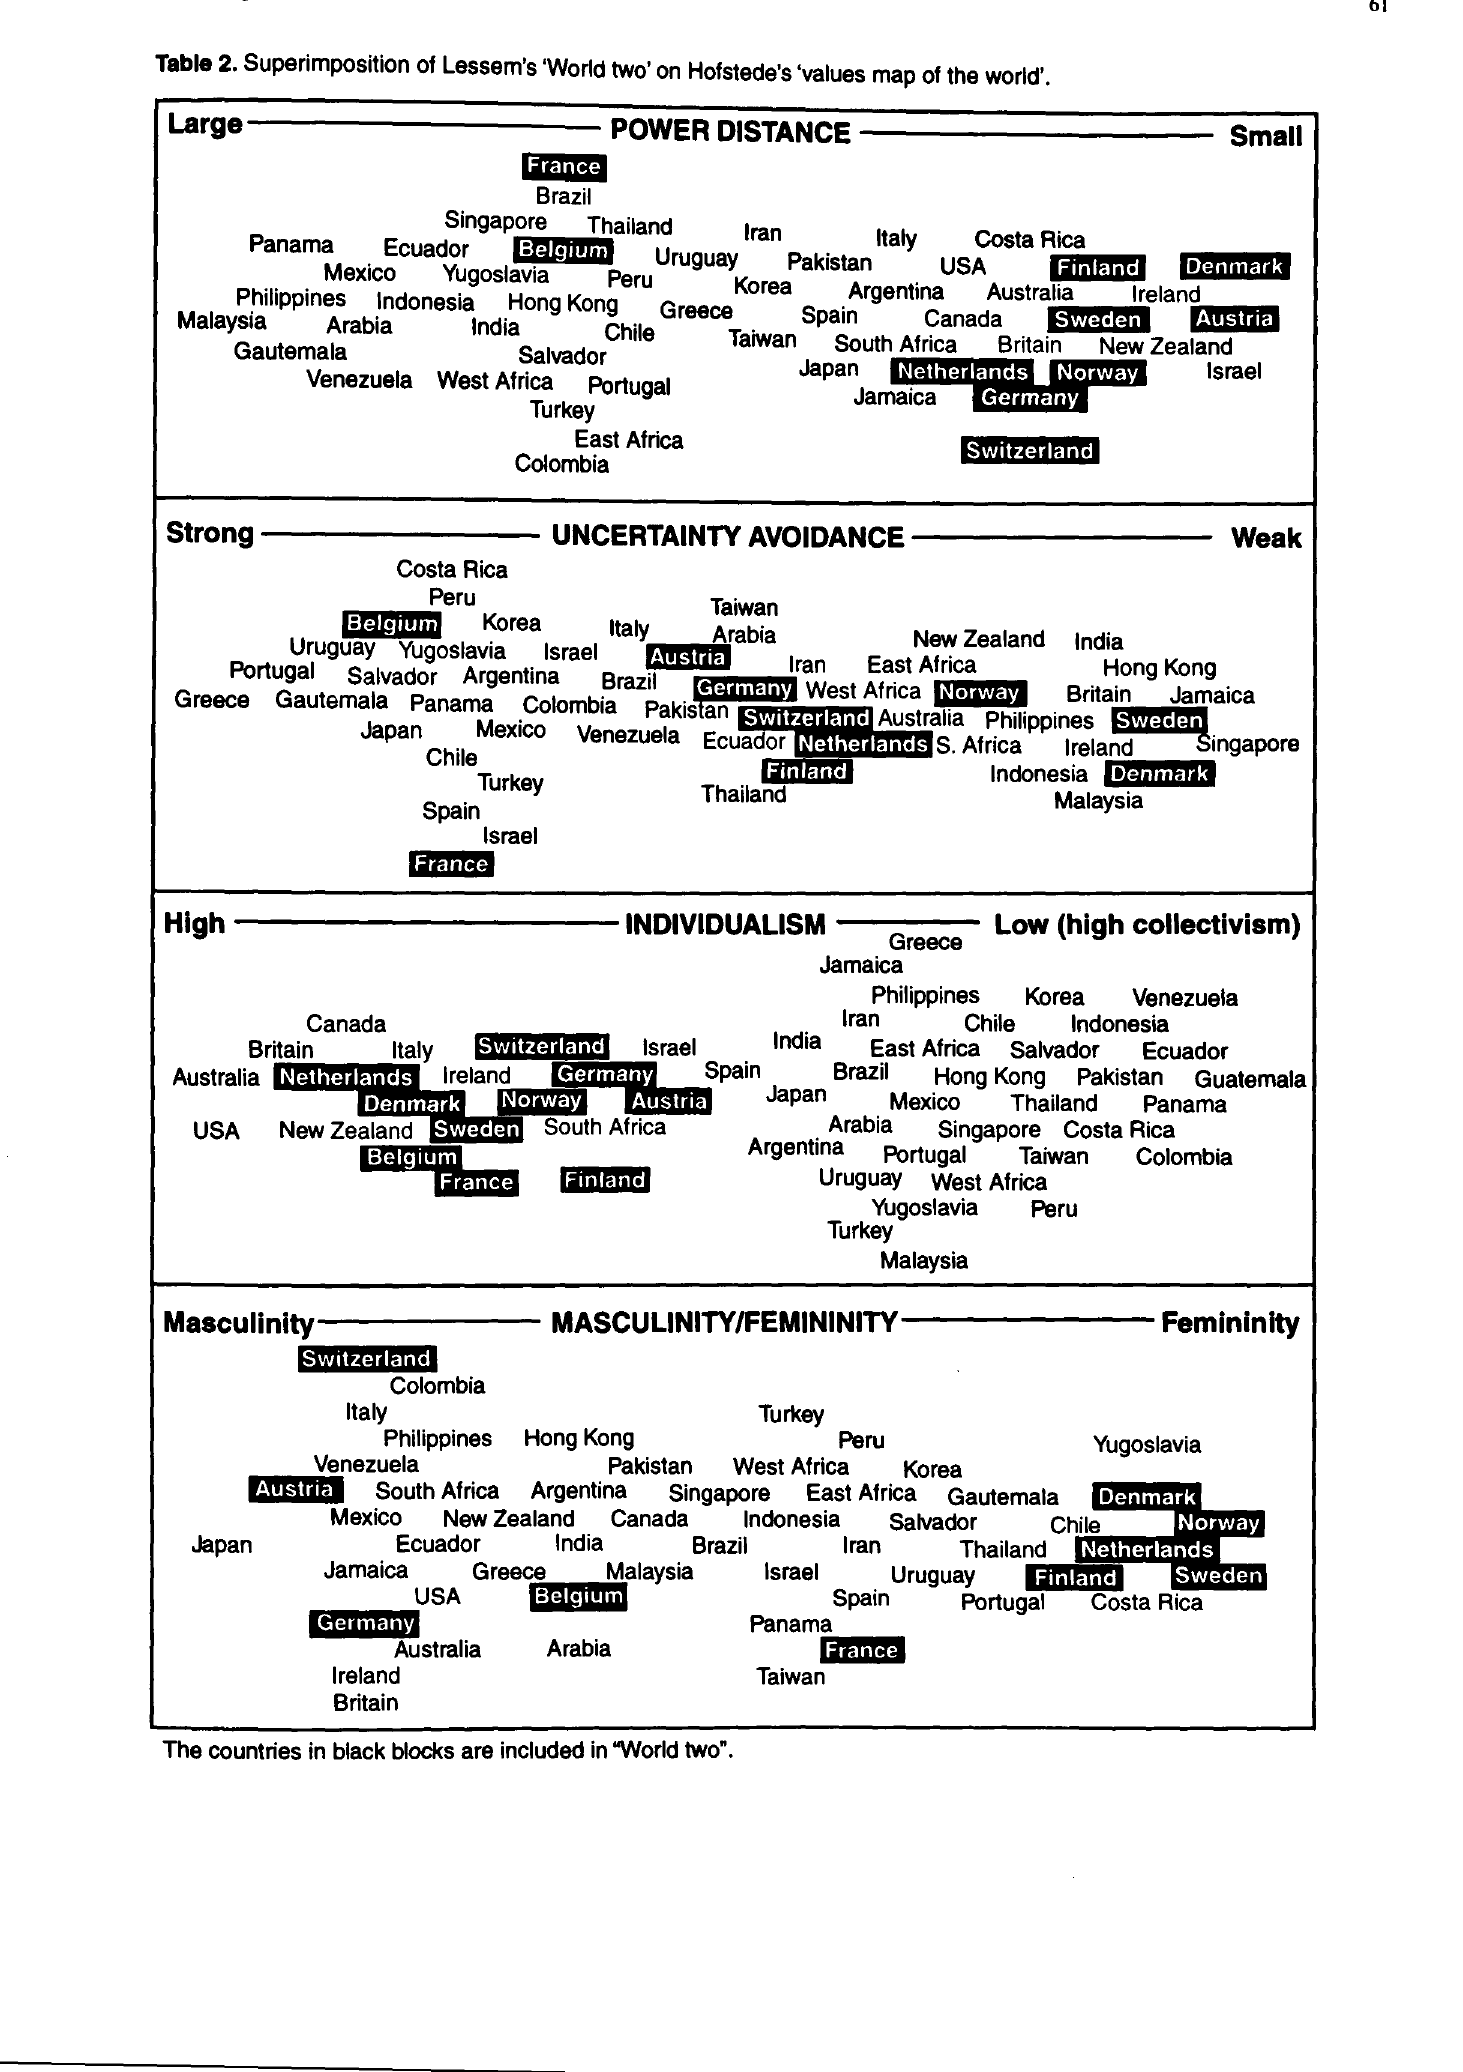
The countries in black blocks are included in "World